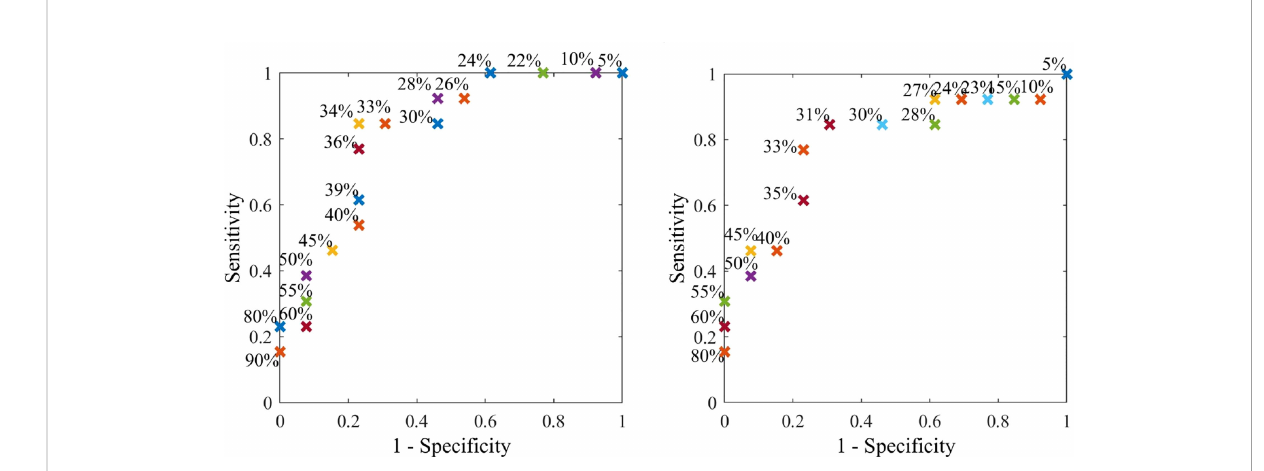
FIGURE 9 Discrete ROC curve showing diagnostic method applied at different percentage tolerances for breast con fi guration